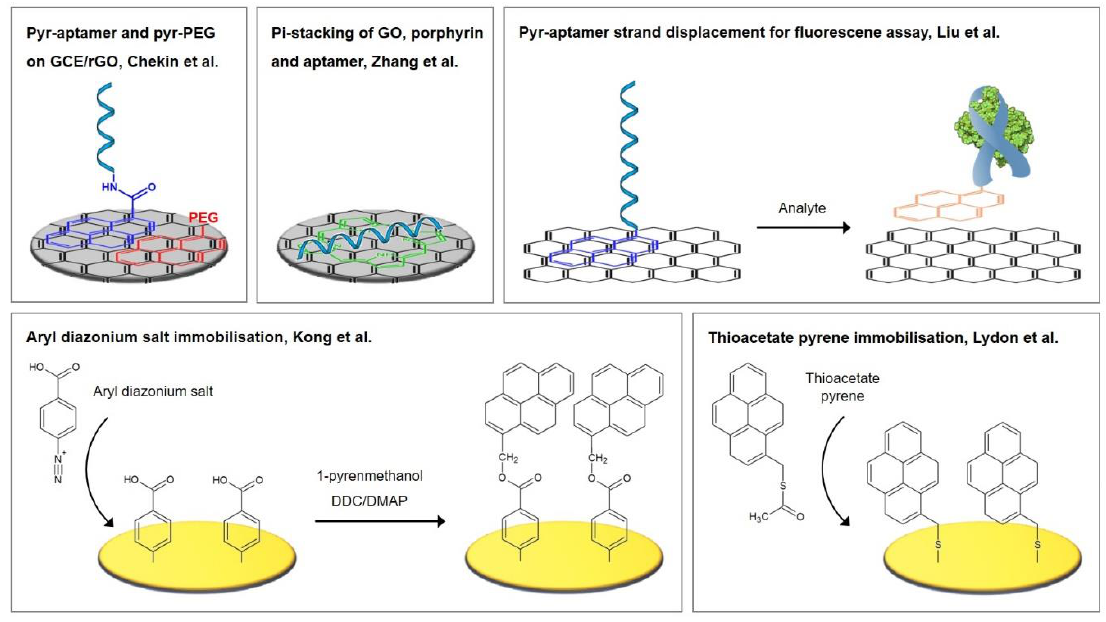
Figure 24. Schematic presentation of possible strategies incorporating π–π interactions with pyrene for aptamer immobilization [22,162,163,170,173,174]. aptamer immobilization